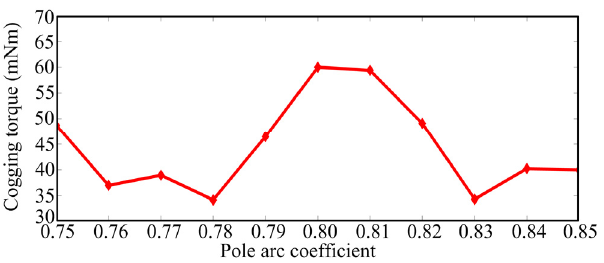
Figure 9. Effect of pole arc coefficient on cogging torque in a machine with an 8-pole and 27-slot combination.